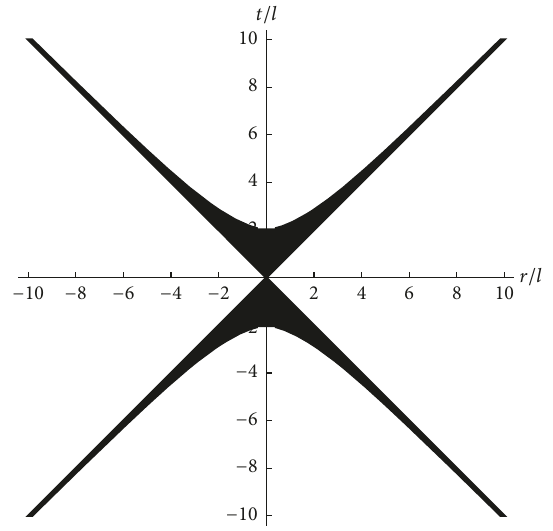
Figure 2: Spacetime region where the microcausality violation occurs (in the case N = 2